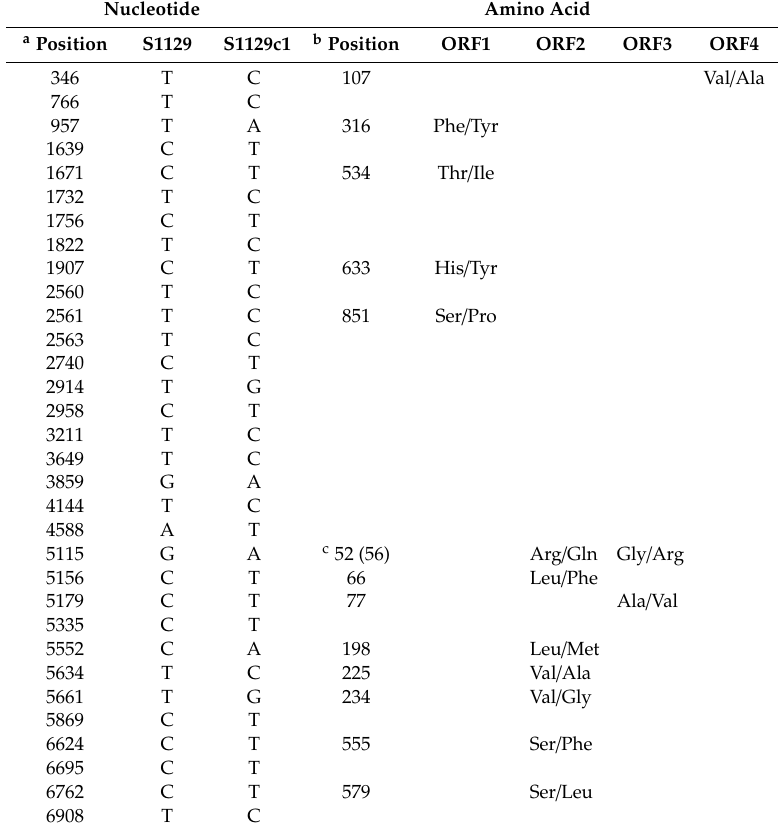
Table 1. Nucleotide and amino acid changes in S1129c1 during passages. Nucleotide Amino Acid